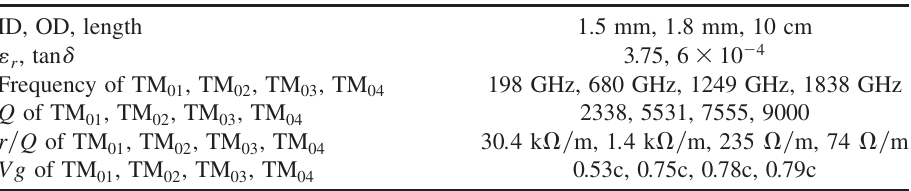
TABLE III. Main parameters of a dielectric wakefield accelerator to demonstrate a high transformer ratio.